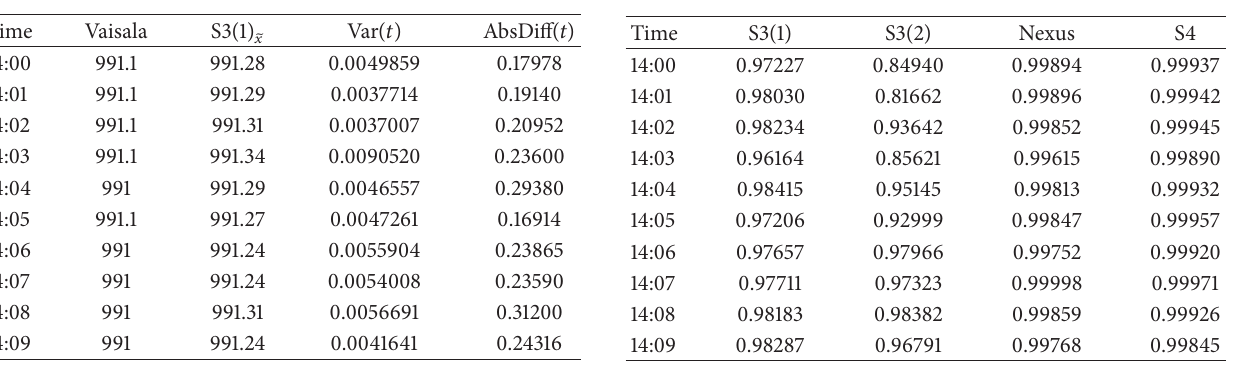
Table 9: Calculated 𝑊 𝛼 of different device models.